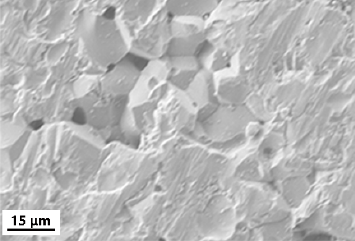
Figure 2. SEM images of MnZn ferrite surface .